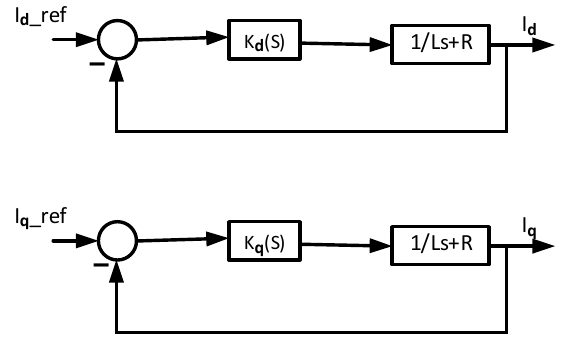
Figure 8. Simplified current control loop in dq frame.